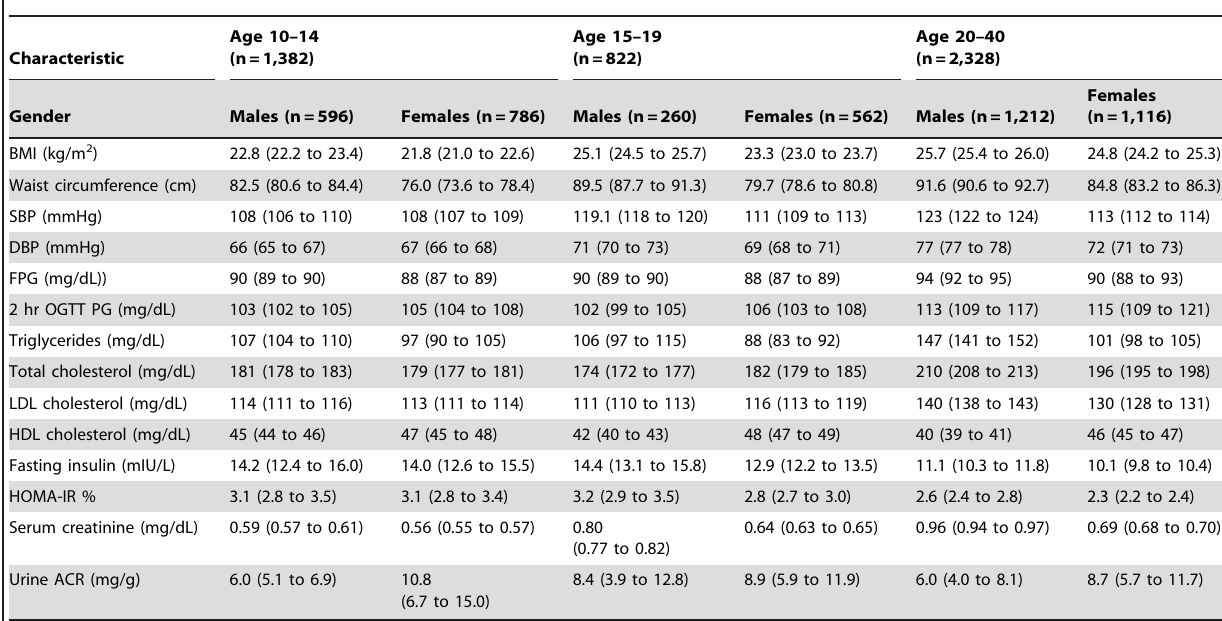
Table 2. Baseline clinical and biochemical characteristics of 4532 subjects aged between 10–40 years with $ 2 cardio-metabolic risk factors selected for participation in the randomized controlled